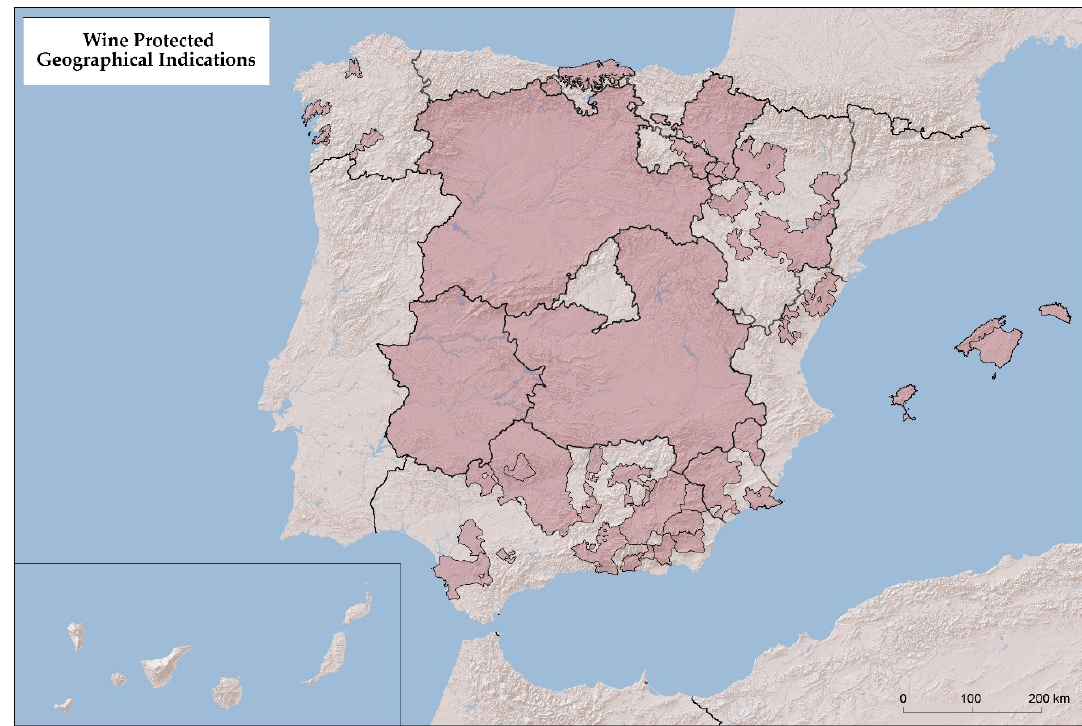
Figure 10. Spanish wine PGI registered in the European Union. Source: European Commission. eAmbrosia. The EU geographical indications register. Retrieved from: https://ec.europa.eu/geographical-indications-register/ [last consulted on 20 January 2022] and Spanish Ministry of Agriculture, Fisheries and Food. Own elaboration. Table 2. Evolution of vineyard area and PDO in